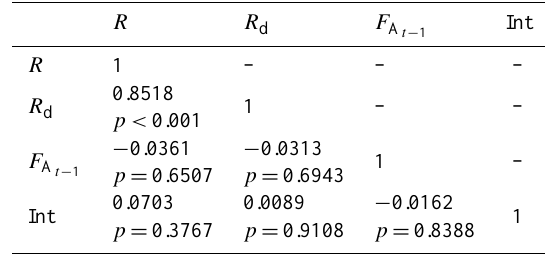
Table A6. Pearson correlation matrix of the variables included in the final linear model to reconstruct historical flood area on the Fortescue Marsh, NW